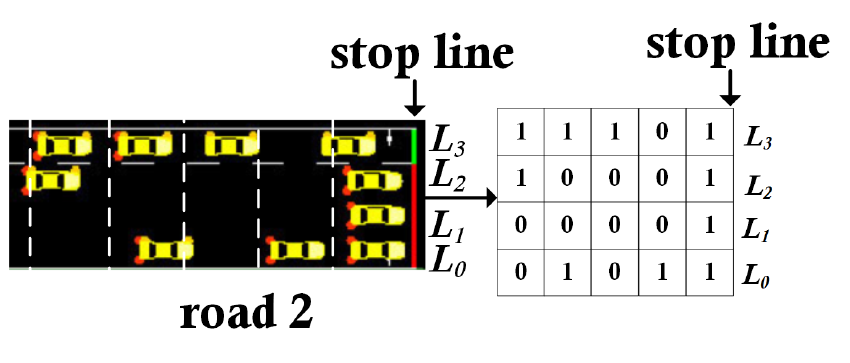
Figure 5. The intersection state defined as a matrix. All states are extracted from incoming